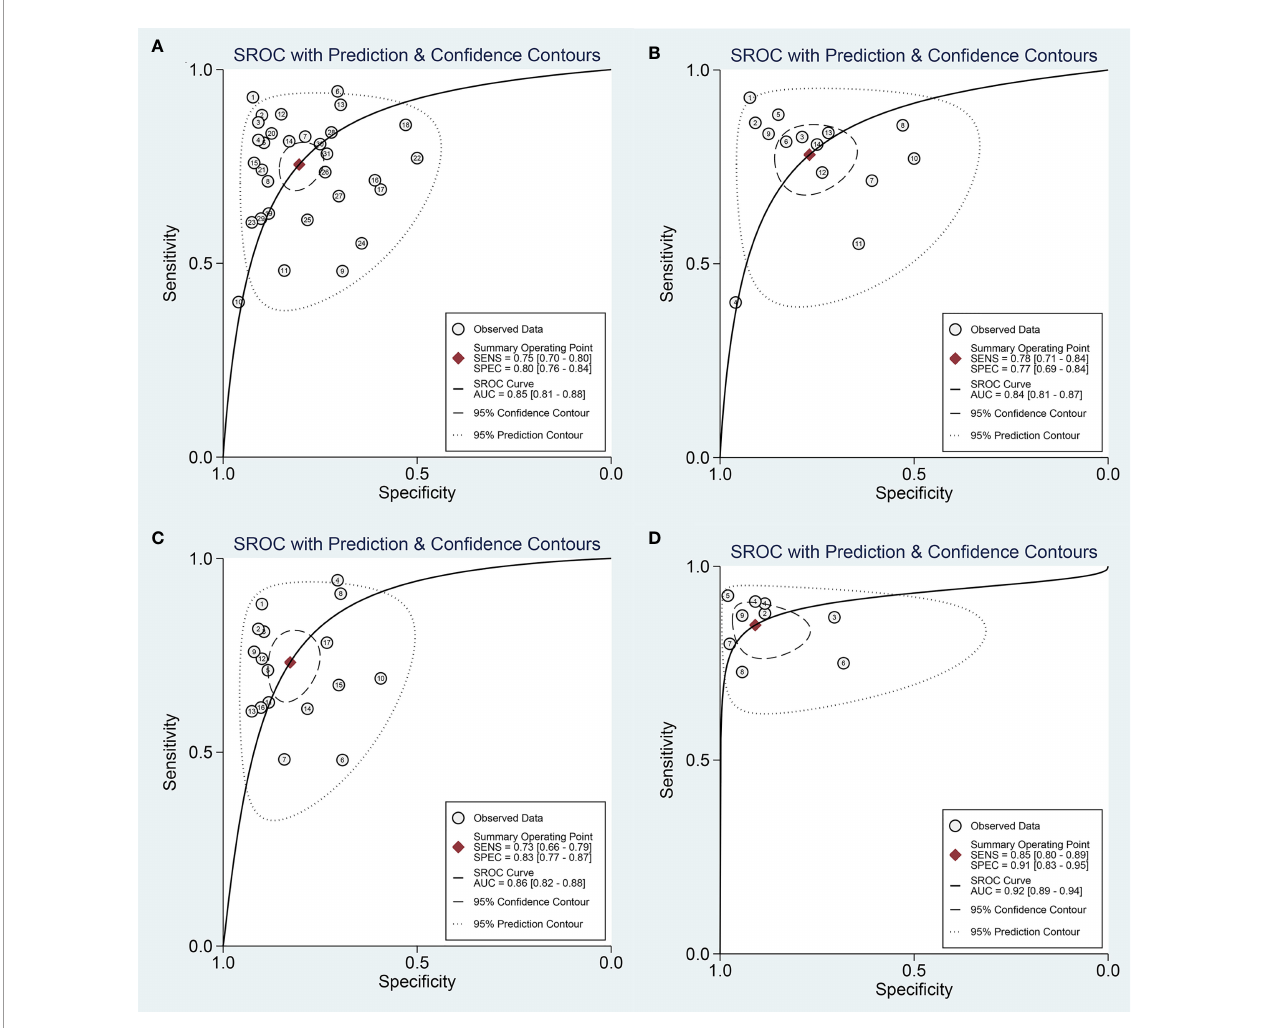
FIGURE 3 | Summary receive operating characteristic (SROC) curve for miR-221/222 in the diagnosis of PTC. (A) SROC curve for using one of miR-221/222; (B) SROC curve for single miR-221; (C) SROC curve for single miR-222; (D) SROC curve for combination biomarkers containing both miR-221/222.